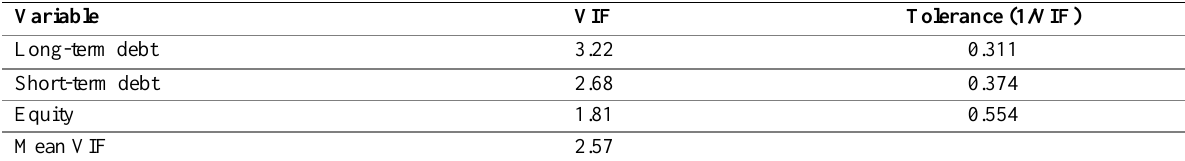
Table 1: Results of Multicollinearity test